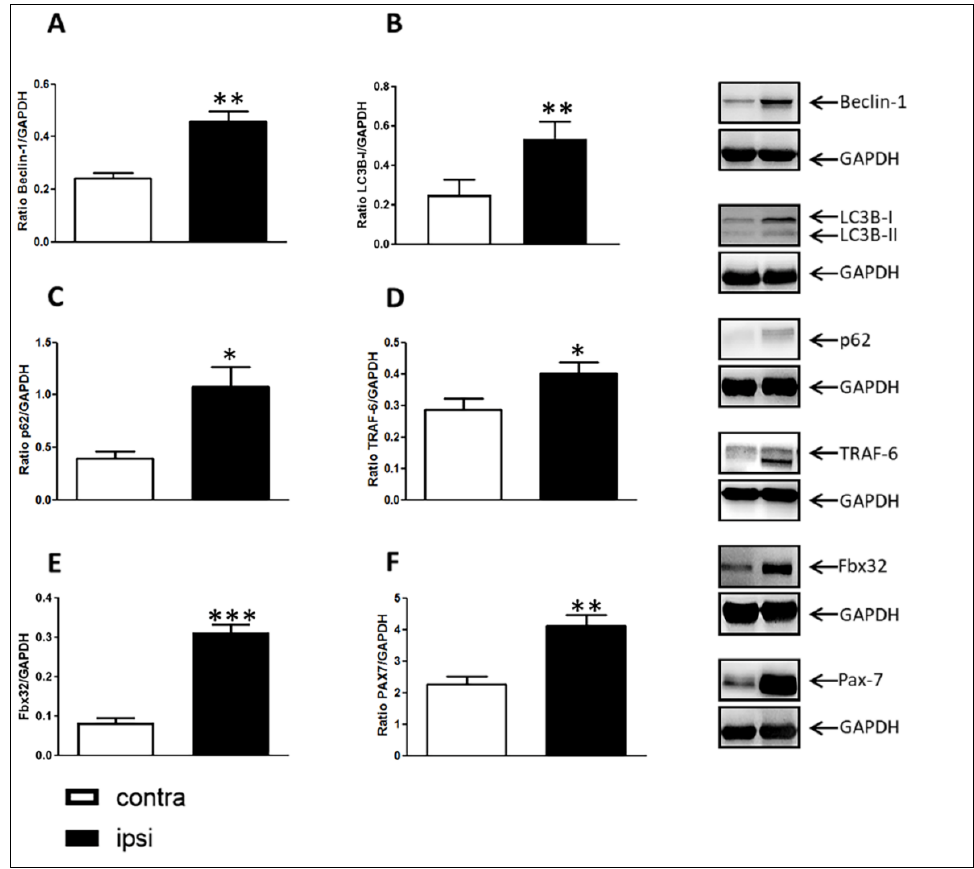
Figure 8. Western blotting images and densitometric analysis of markers analyzed in gastrocnemius muscle on day 28. Protein expression of Beclin-1 ( A ), LC3B-I ( B ), p62 ( C ), TRAF-6 ( D ) and Fbx32 ( E ) markers were higher in injured ipsilateral GC compared to those of contralateral muscle. Densito- metric analysis revealed that Pax-7 expression levels ( F ) were also higher than those in contralateral muscle. Results are expressed as mean ± S.E.M. *: p < 0.05, **: p < 0.01, ***: p < 0.001 vs. contralateral.